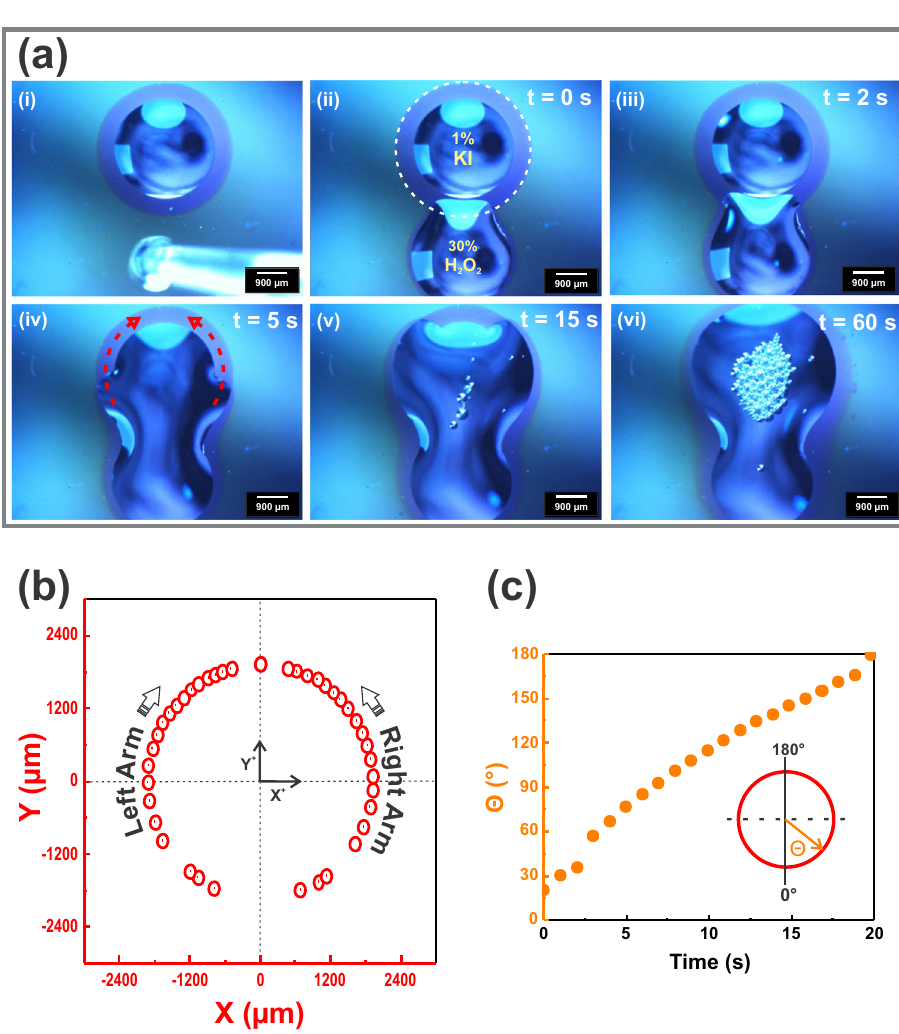
Fig. 6 Droplet engul fi ng dynamics. a Sequenced images to show a droplet engulf droplet behavior (see also Supplementary Movie 4). The H 2 O 2 droplet extends a “ phagocytic cup ” in response to interaction with the fl uid released through the nanopores from the KI droplet. A growth of projected arms is then directed to surround the KI droplet and fi nally the tips of the arms meet and fuse to engulf it. The dotted white line in the second panel marks the extrapolation of the contours of the guiding annulus self-generated in the KI droplet periphery. The red arrows in the fourth panel illustrate the path followed by the outstretched arms of the H 2 O 2 droplet maneuvering around the KI droplet. b Two-dimensional trajectory of the arms extension. c Dependence of the rotational orientation angle of the right arm ( θ ) against the time. The arms are driven to rotate in a directed pathway surrounding the KI droplet. Time interval between the dots in the curves is